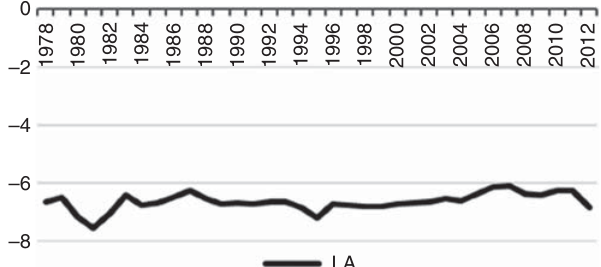
Figure 6. Logarithm of per capita air transportation